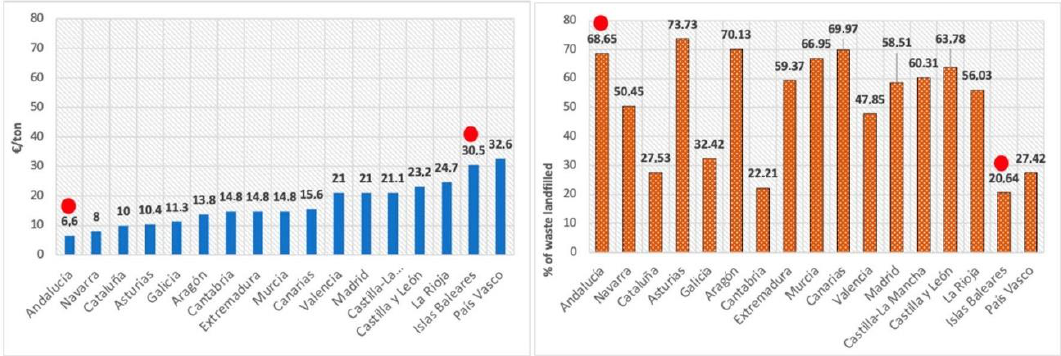
Figure 6. Comparison between disposal prices and the waste destined for landfills in Spanish terri- tory